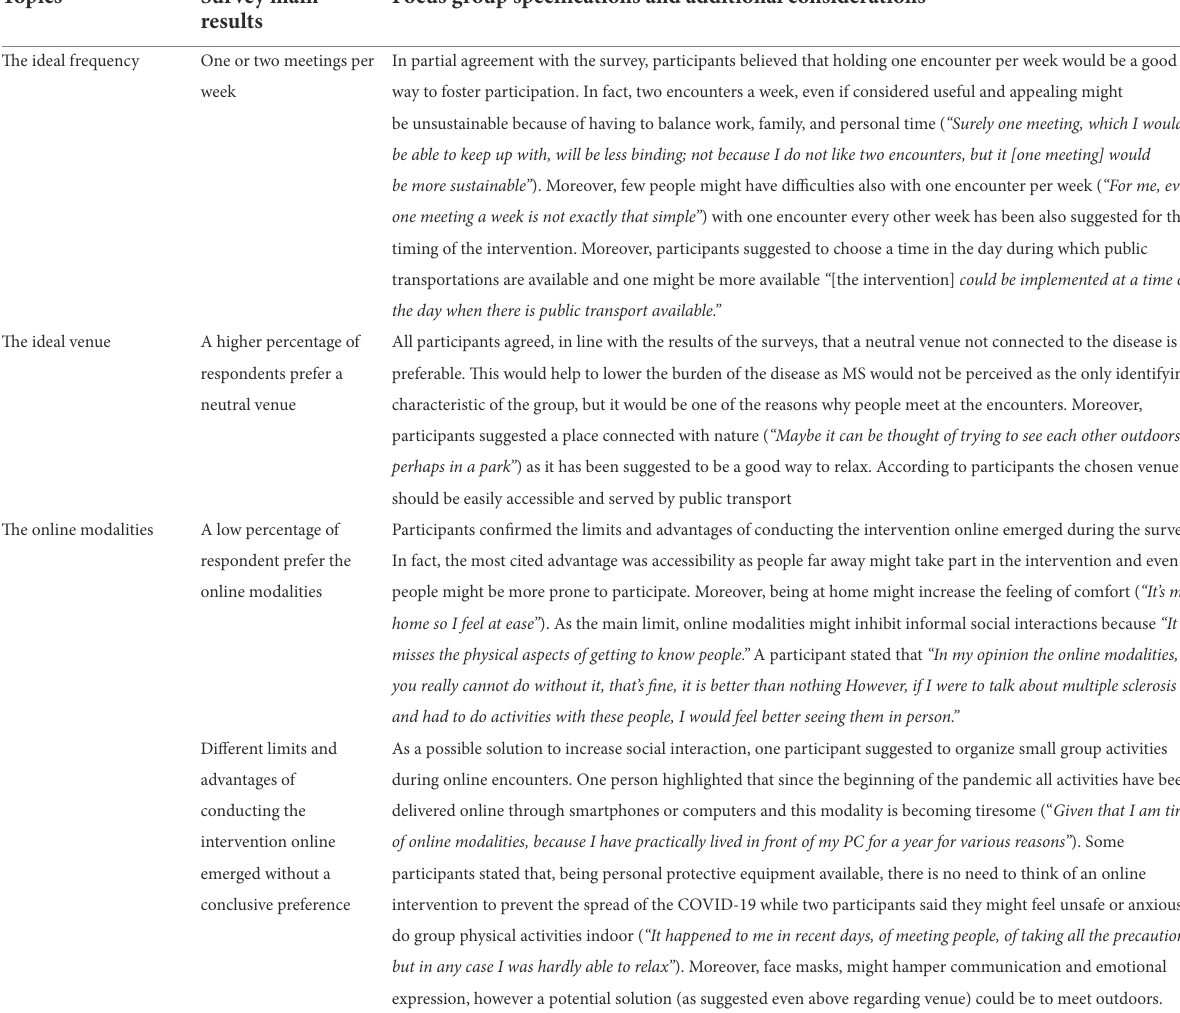
TABLE 6 Synthesis of the focus group with YawMS in comparison with the main results of the survey: needs and preferences regarding intervention timing, venue, and modalities.